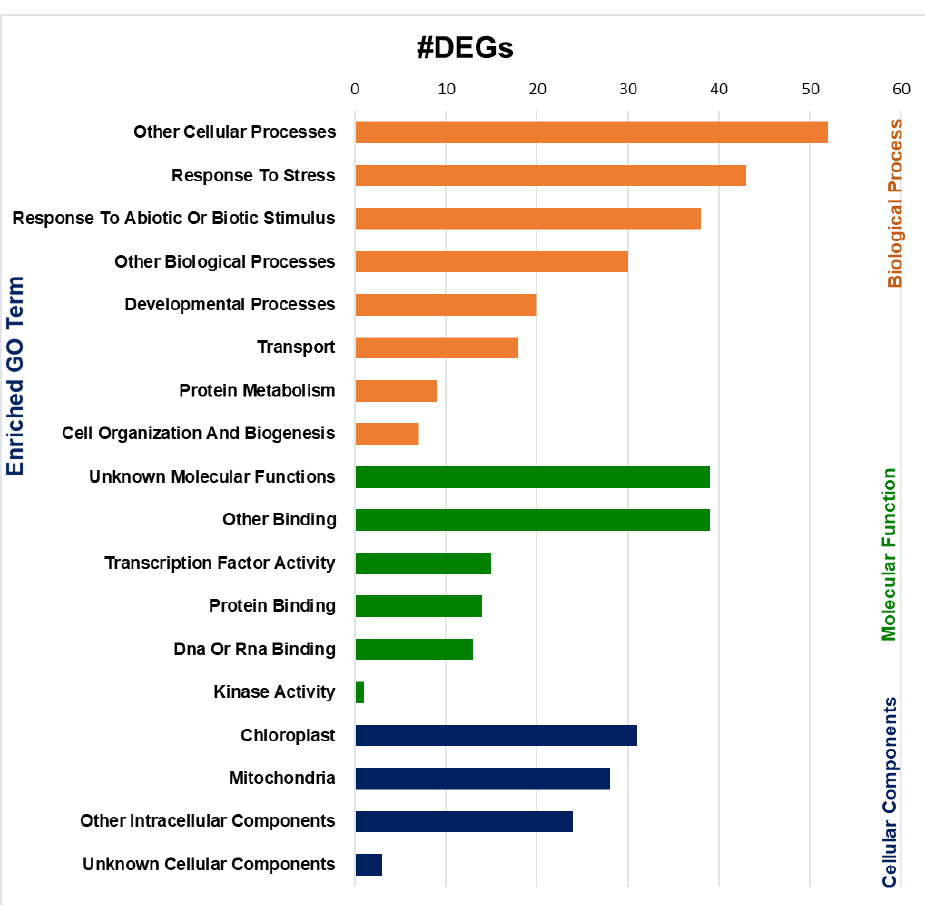
Figure 9. Enriched gene ontology terms from the classification of 131 DEGs shared by Col-0, Cvi-0, and U112-3 ecotypes.